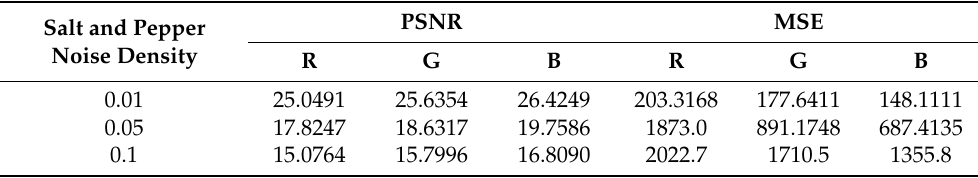
Figure 7. Cropping attack analysis. ( a – c ) Cropped cipher images; ( d – f ) corresponding decrypted images. Table 9. Noise attack analysis.